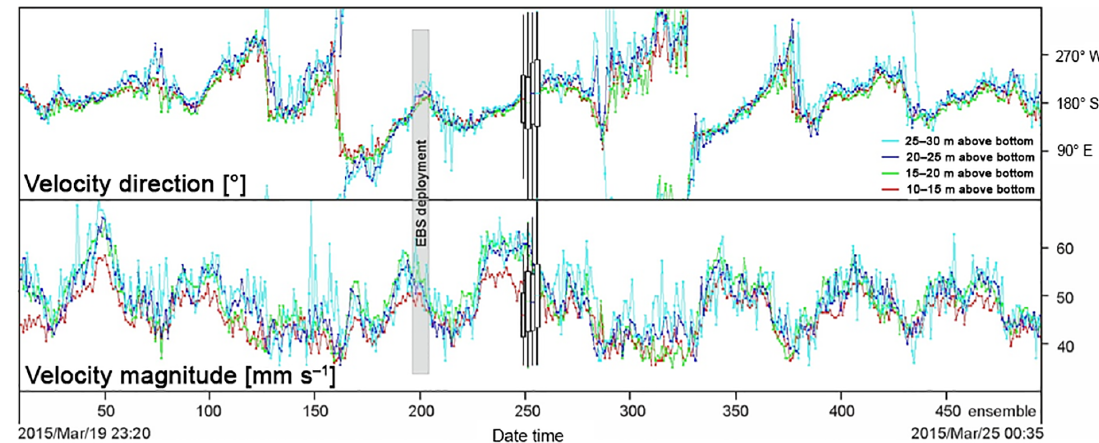
Figure A5. ADCP data obtained by a DOS lander deployment during SO239 indicating a SSW current flow during the EBS deployment (grey shaded box; ensemble 196 to 204). Box plots show the mean and standard deviation of the time series of the entire deployment. Mean currents between 10 and 30m above the bottom are towards the south with about 50mms − 1 .